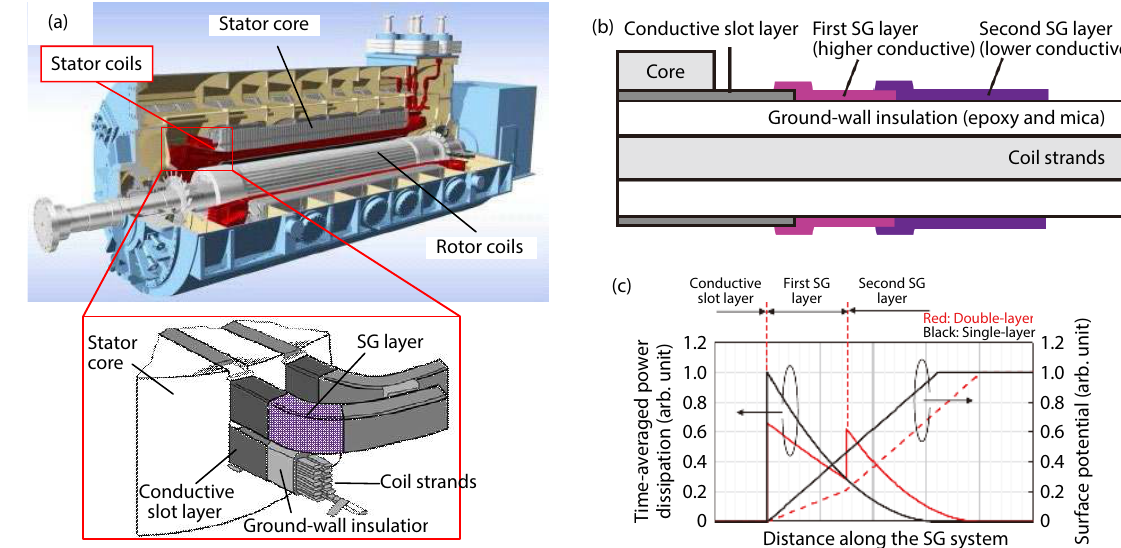
Fig. 4 Examples of SADs used in motor coils. ( a ) Schematic of a turbogenerator and typical insulation structure of the end-turn stress grading system. ( b ) Cross- section of the double-layer stress grading system. ( c ) Distributions of surface potential and time-averaged power dissipations along the stress grading systems. Repro- duced with permission from ref. [97], © 2020